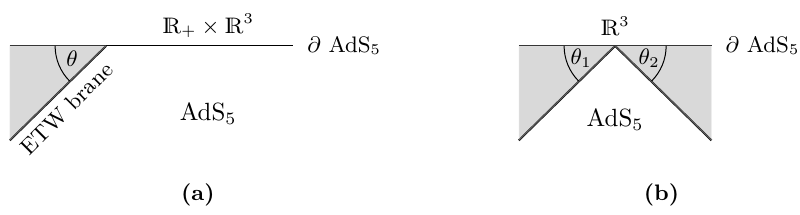
Figure 13. Left: braneworld realization of a holographic dual for a 4d BCFT. AdS 5 is cut off by an end-of-the-world brane, leaving a half space of the conformal boundary. Right: wedge holography dual for a 3d CFT involving two end-of-the-world